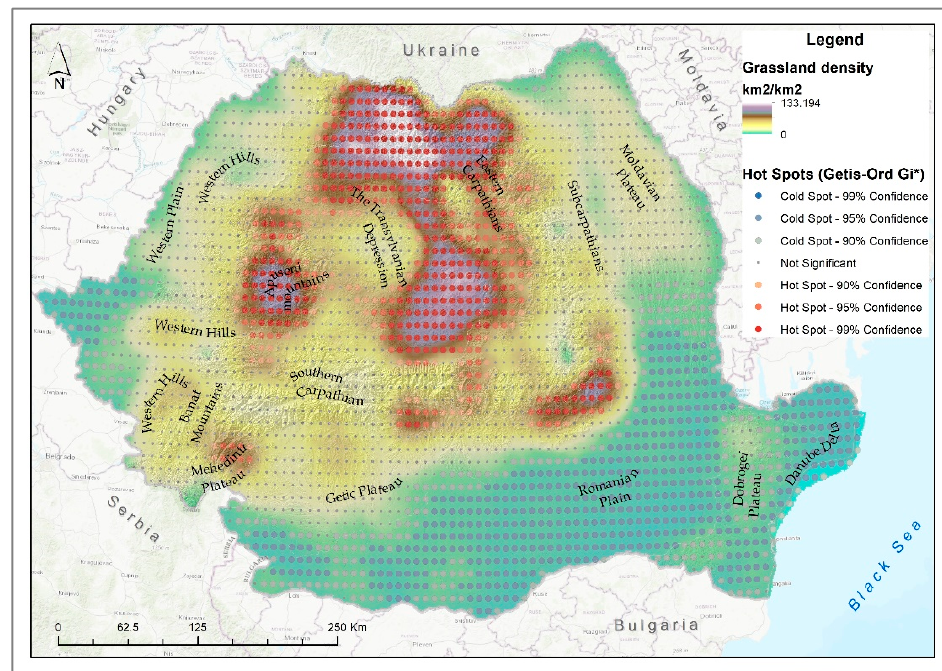
Figure 5. Grassland degraded ecosystem density and hotspot analysis.